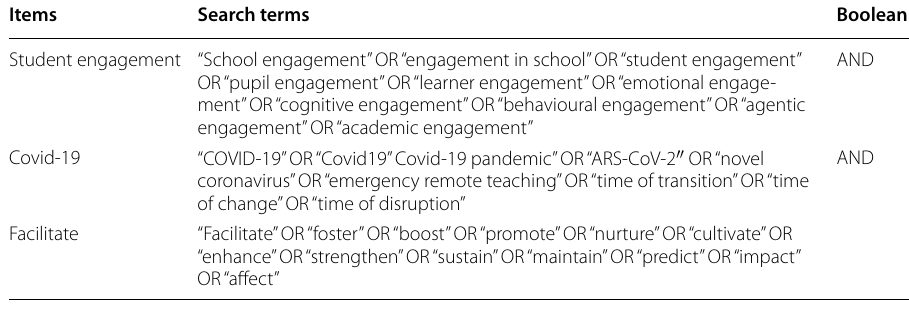
Table 1 Search terms and strings Items